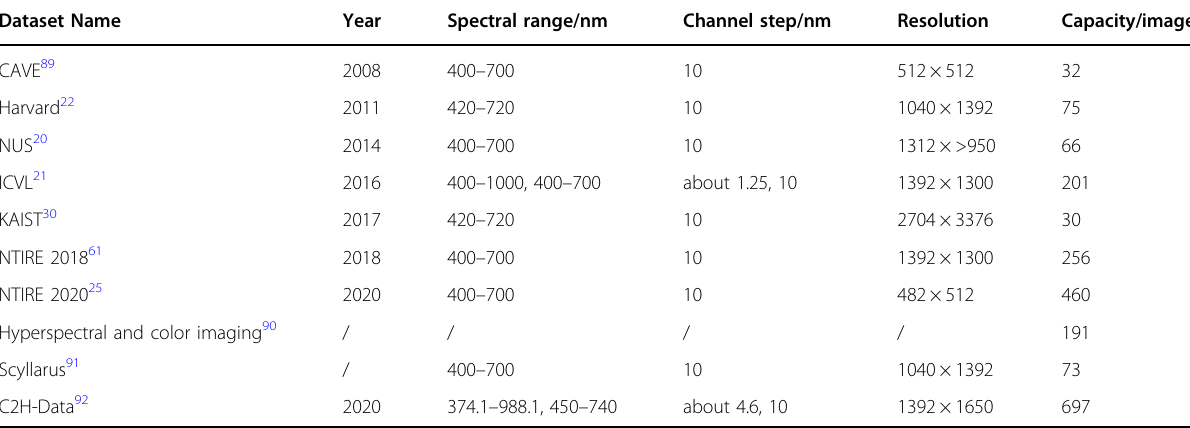
Table 3 Spectral dataset